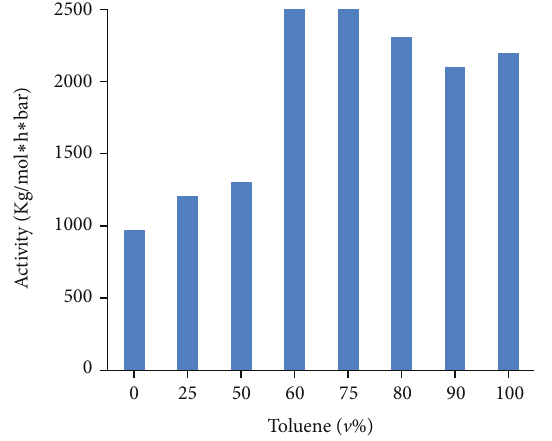
Figure3:Catalystactivityversusvolume%oftolueneinthereaction medium.